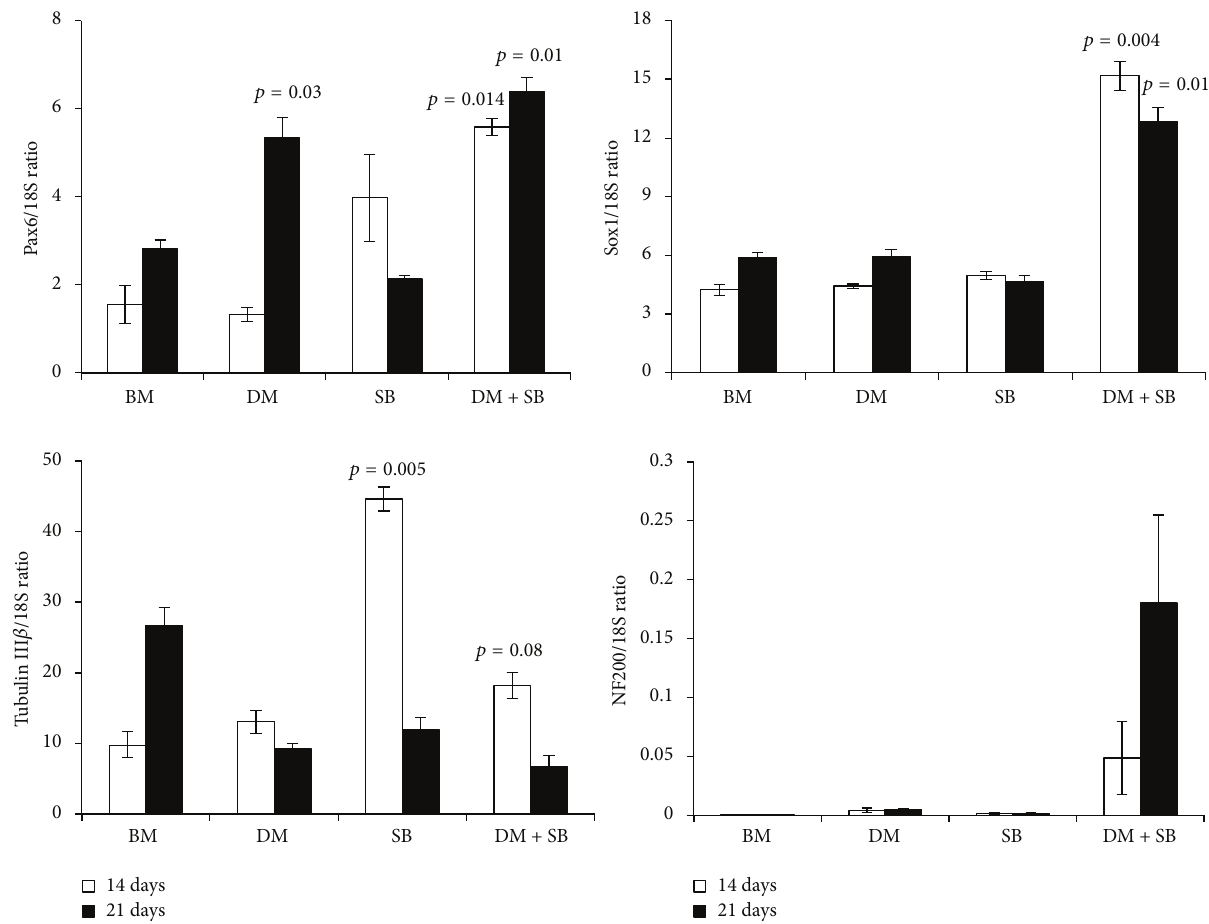
Figure 3: mRNA expression of neuronal markers in hADSCs upon dual inhibition of activin/nodal/TGF- 𝛽 and BMP signaling pathways. hADSCs were cultured in BM or BM containing either activin/nodal/TGF- 𝛽 pathway inhibitor SB or BMP pathway inhibitor DM or both for 14 and 21 days. The cells were harvested after 14 and 21 days to isolate RNA and prepare cDNA. Using gene specific primers and real- time PCR, expression of neuron cell specific transcription factors (Pax6 and Sox1), immature neuronal marker (tubulin III 𝛽 ), and matured neuronal marker (NF200) was quantified. 𝑝 values are denoted compared to respective BM group. kept chilled in a syringe until injected in the mice.